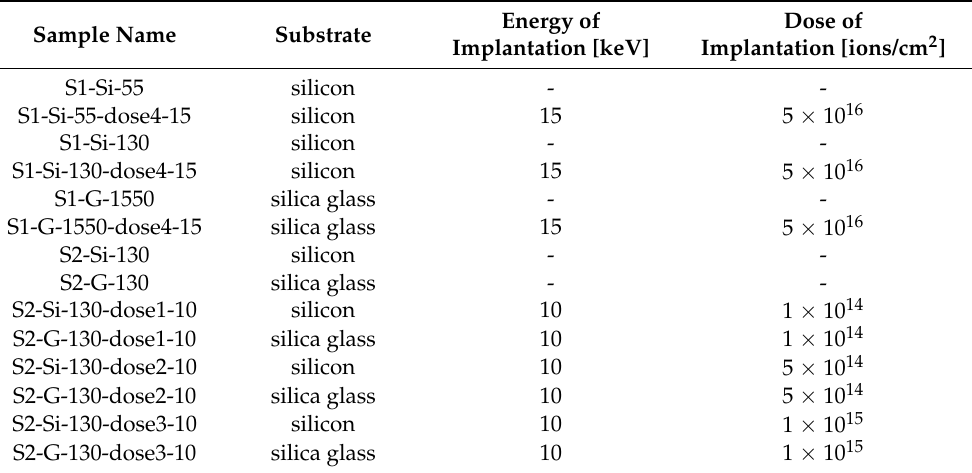
Table 2. List of studied CuO samples with information about the substrate used during deposition and conditions of ion